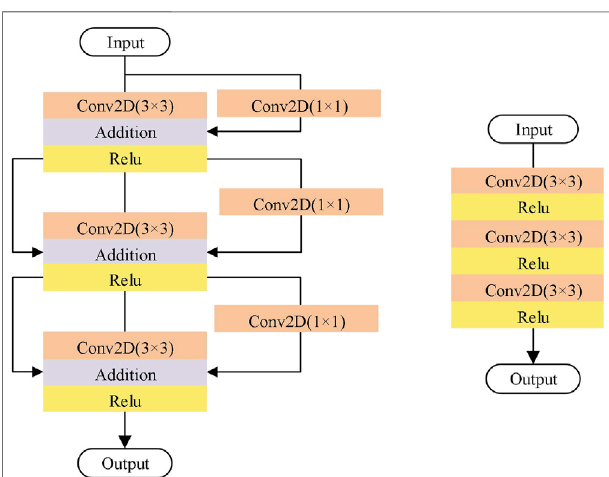
FIGURE 2 | RepVGG block. RepVGG-A1 is divided into fi ve stages, and the number of the layers of each stage are 1, 2, 4, 14 and 1, respectively. Training stage (Left): in the fi rst layer of each stage, down sampling is carried out through convolution with step size of 2, and there is no identity branch. Inference stage (Right): AL-Net becomes a single branch after reparameterization. Only the three layers of one stage are shown